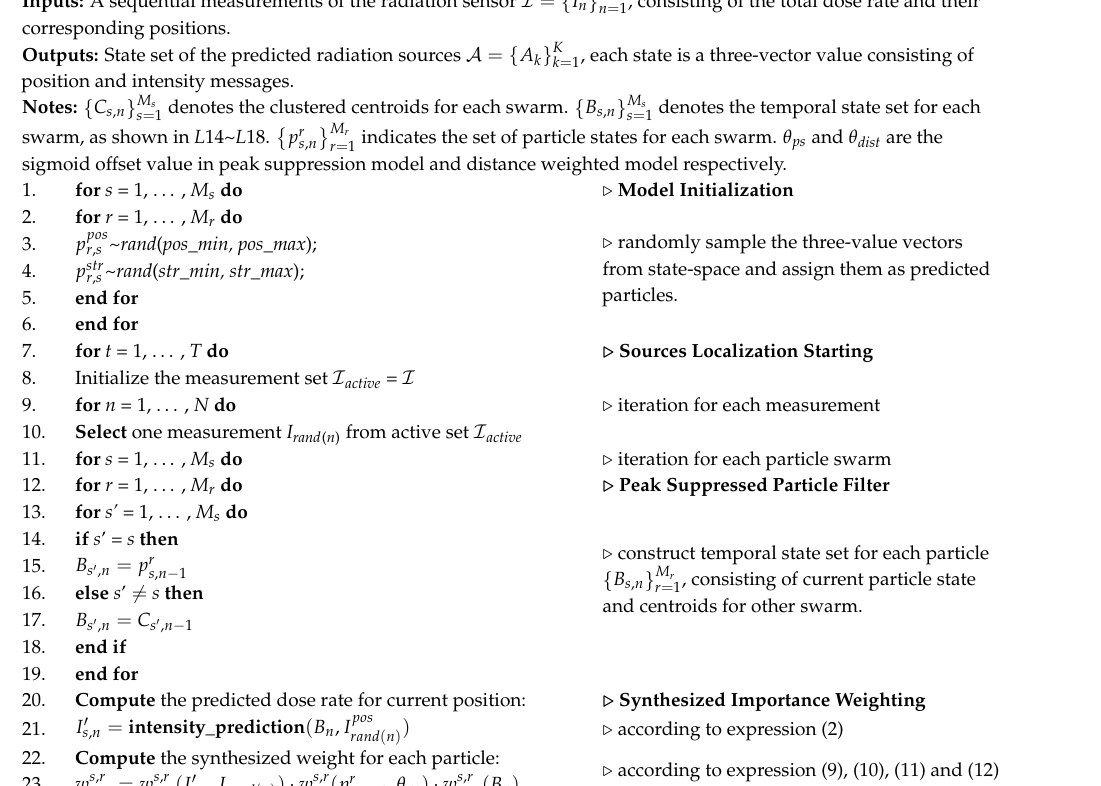
Figure 3. Flow diagram of the proposed PSPF